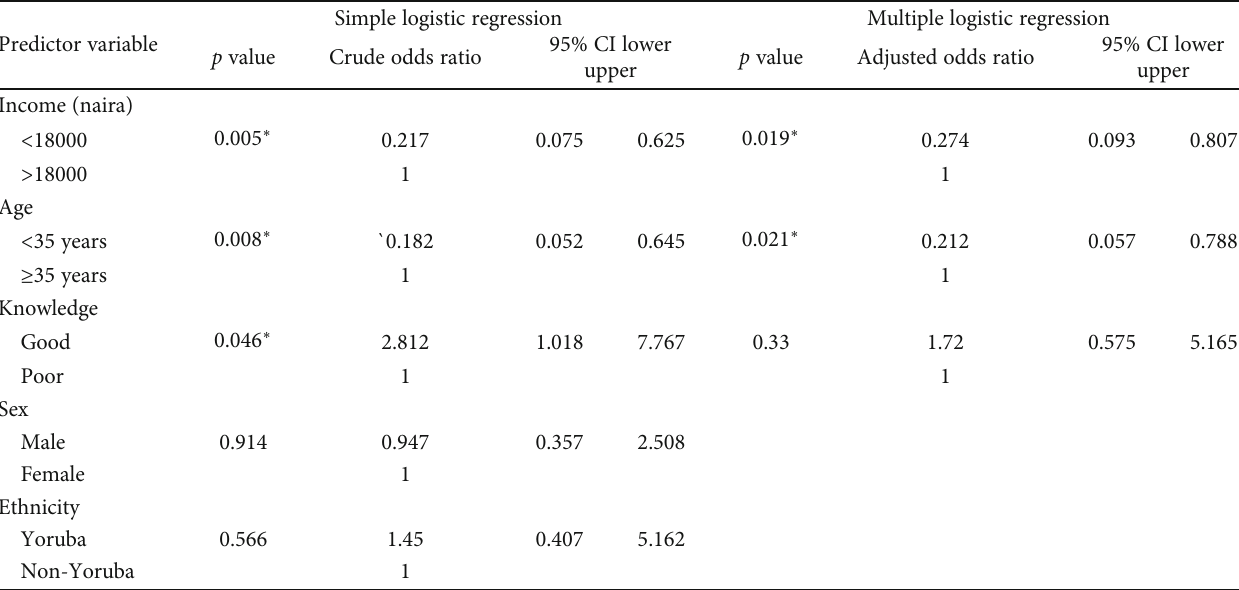
Table 10: Simple and multiple logistic regressions of TB-associated stigma on associated factors in urban communities. Predictor